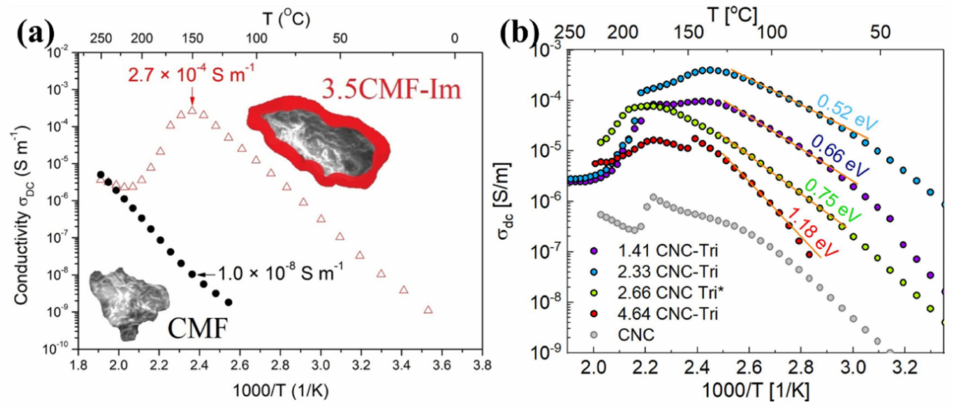
Figure 3. Proton conductivity of ( a ) cellulose microfibers functionalized with imidazole molecules. Reprinted with permission from Ref. [109]. Copyright © 2019 Elsevier B.V. (License Number: 5413030049297). ( b ) CNC doped with 1H − 1,2,3 triazole